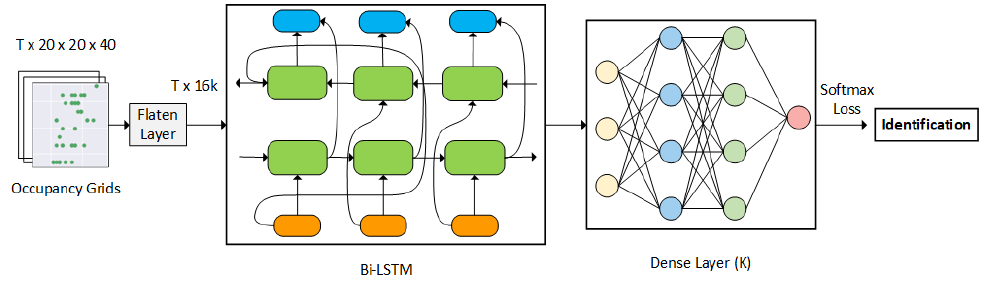
Figure 3. User classification